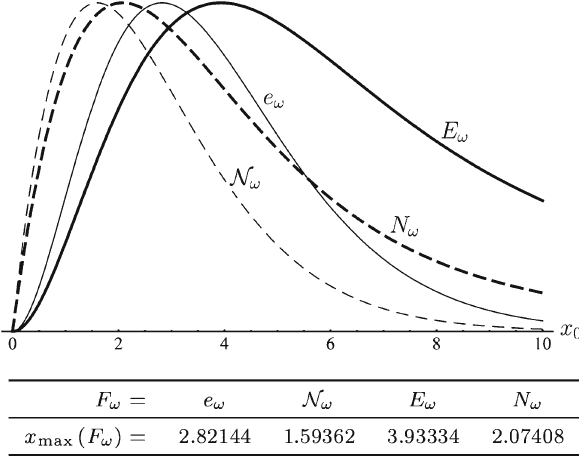
Fig. 1 All the four spectral functions discussed in the paper. Since the functions are expressed in different physical units, they have been all normalized to a common “one”, by convention, and the vertical axis has been removed. Numerical values, denoted by x max ( F ω ) , of the dimensionless frequency x 0 defined in (25), corresponding to maxima of the spectral functions are given in the table